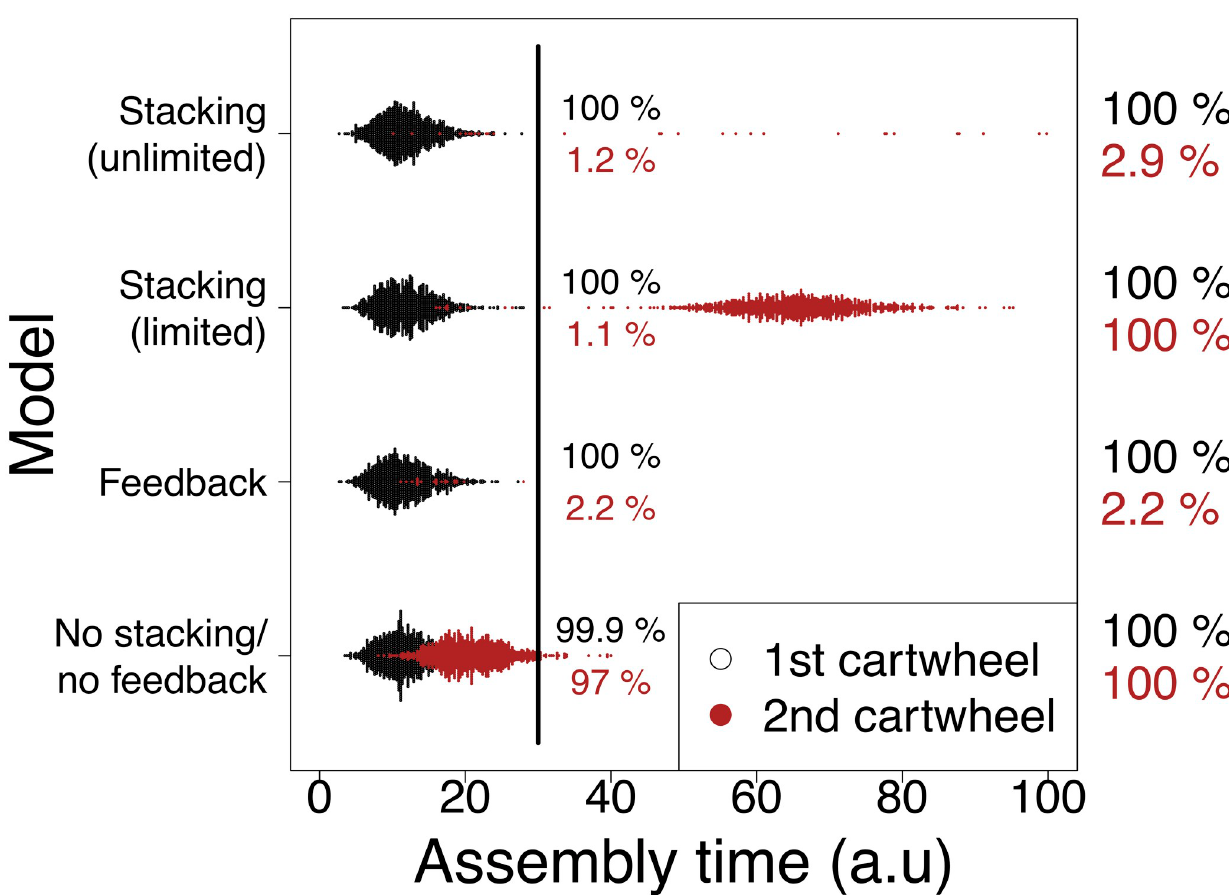
Fig 6. Assembly times of the first and second cartwheels under different models. The dots indicate the assembly times of the first (black) and second (red) cartwheels in 1000 simulations of the indicated models. The percentages of first (black) and second (red) cartwheels present at t = 30 and when the simulation terminates highlight that supernumerary cartwheels appear earlier in the feedback model when compared to the stacking model(s). We used default simulations conditions as indicated in Fig 3 and in the Models and methods section. For the stacking (limited and unlimited) models k s = 1. Otherwise, k = 0. In the limited stacking model we set h = 6. In the feedback model, we set ρ = α = s